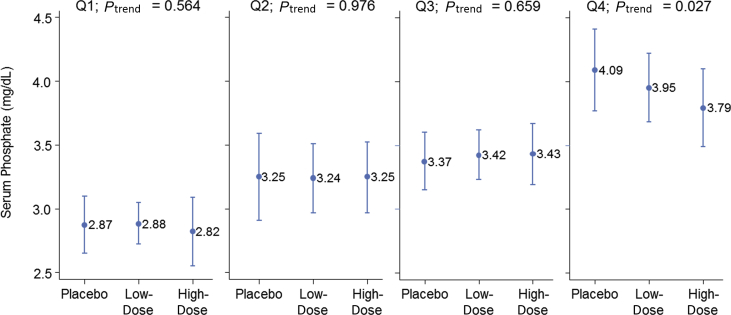
Post hoc analysis of the mean (95% CI) end-of-treatment levels of serum phosphate stratified according to baseline serum phosphate quartile (Q) groups. Q1 = 2.20–2.94 mg/dL; Q2 = 2.95–3.28 mg/dL; Q3 = 3.29–3.62 mg/dL; Q4 = 3.63–4.77 mg/dL; High-dose = 2.4 g of sevelamer per meal; Low-dose = 0.8 g of sevelamer per meal.